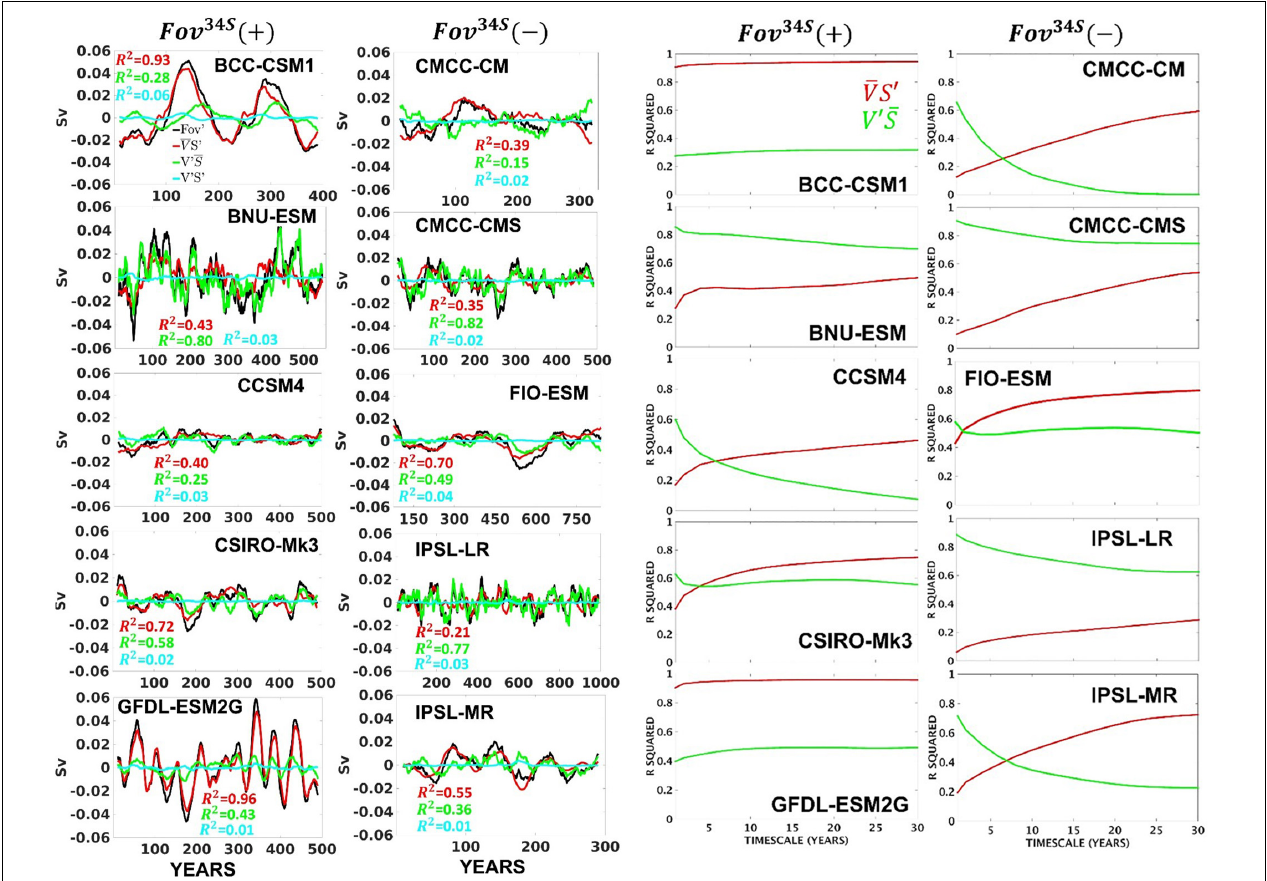
FIGURE 4 | (Left) : Eleven-point running averages of the annual-mean time series of F ov (cid:48) (black lines; Sv), with contributions from salinity (red line) and velocity (green line) variability, as well as from their covariability (cyan line) for the region between 34 ◦ S and 20 ◦ S. The R 2 values between F ov (cid:48) and its components are indicated by the respective colours. Note the different time intervals for each CMIP5 model. (Right) : R 2 of F ov anomalies with contributions from salinity (red) and velocity (green) anomalies, as a function of timescale, for the region 34 ◦ S to 20 ◦ S. The CMIP5 models with positive and negative F ov 34 S are displayed on the left and right panels, respectively, in both